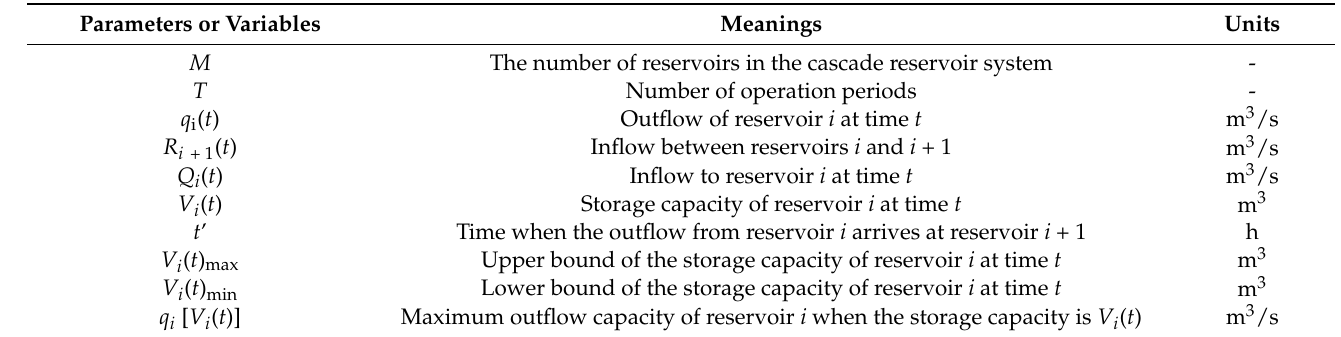
Table 1. Meanings and units of the parameters and